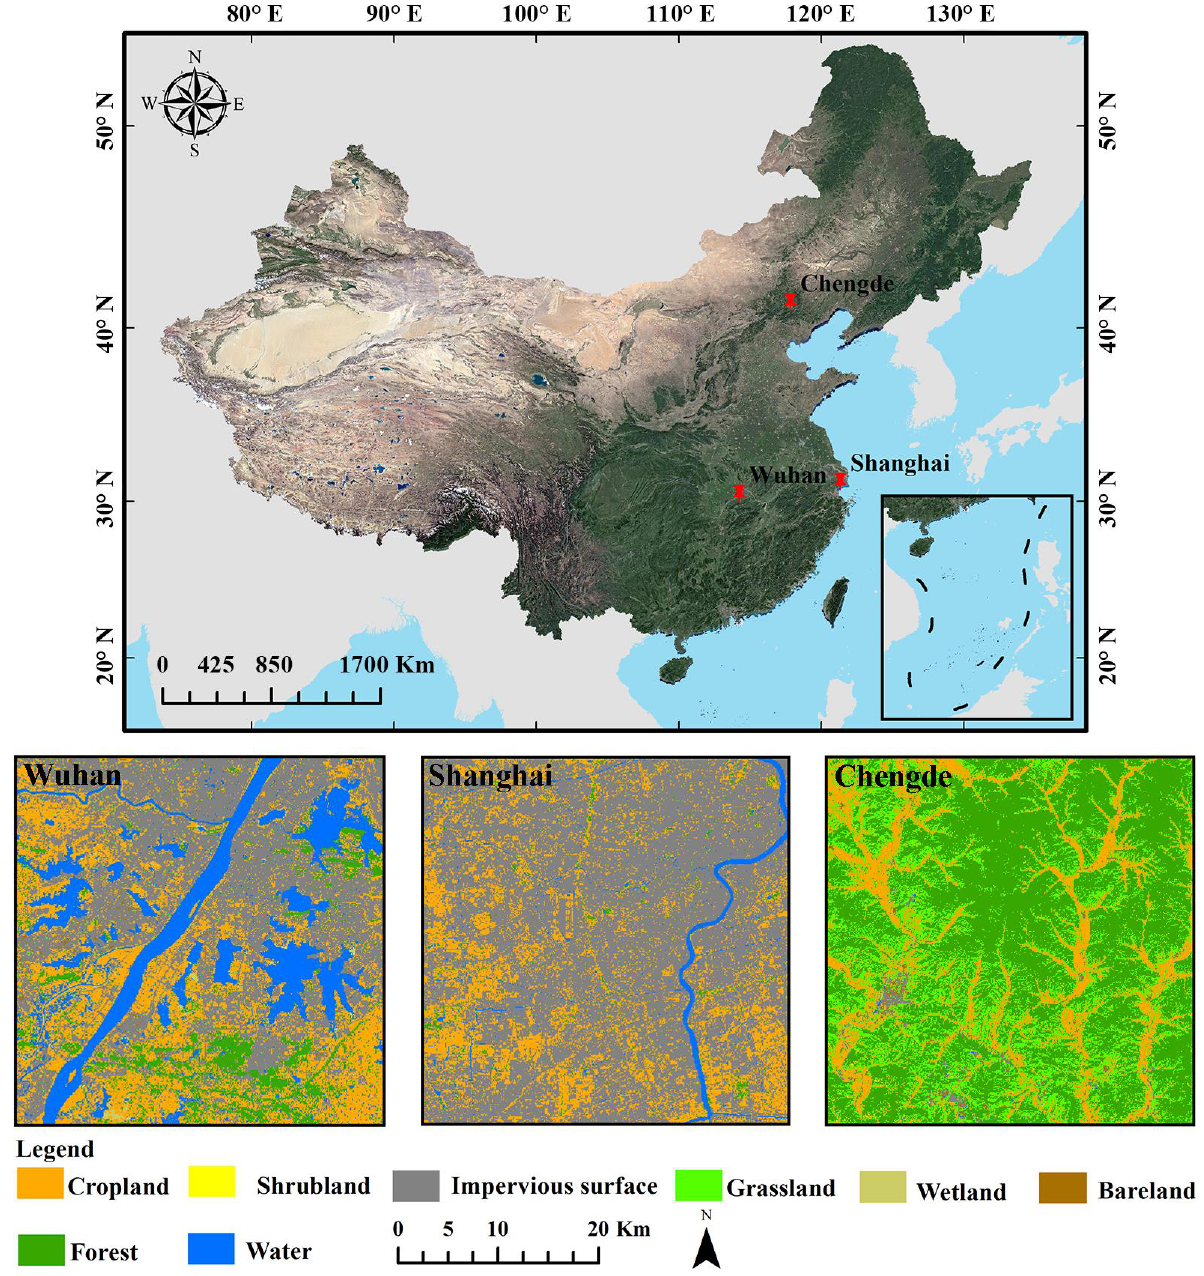
Figure 1. Study area location and land cover types. Land cover type maps are obtained from the Finer Resolution Observation and Monitoring of Global Land Cover.